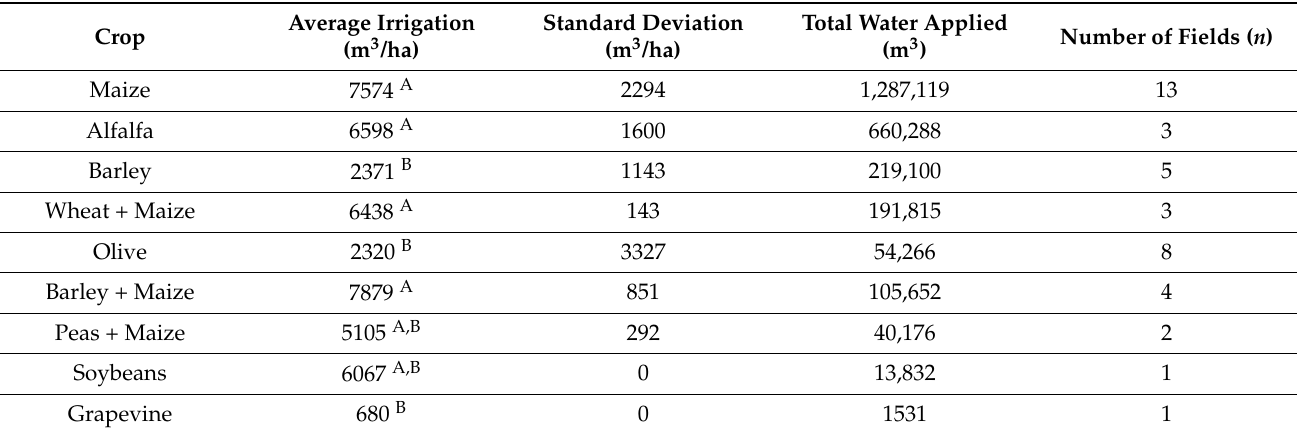
Table 5. Average irrigation and total water applied of the different crops in the AB5 basin during the study period.